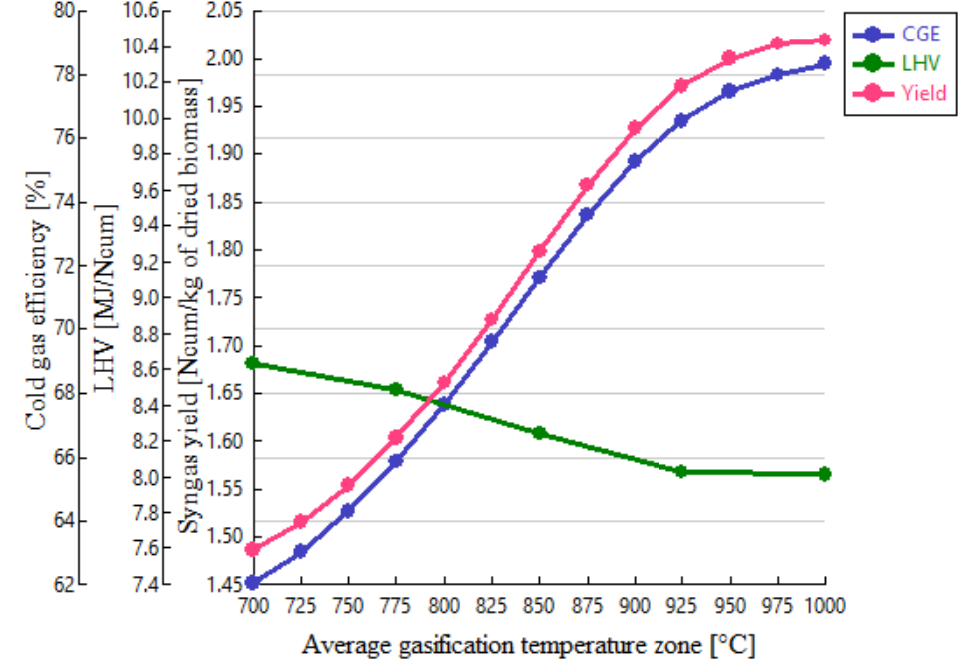
Figure 9. CGE, LHV, and yield rate behavior of syngas as a function of gasification temperature when using oxygen-enriched air (O 2 = 40%).